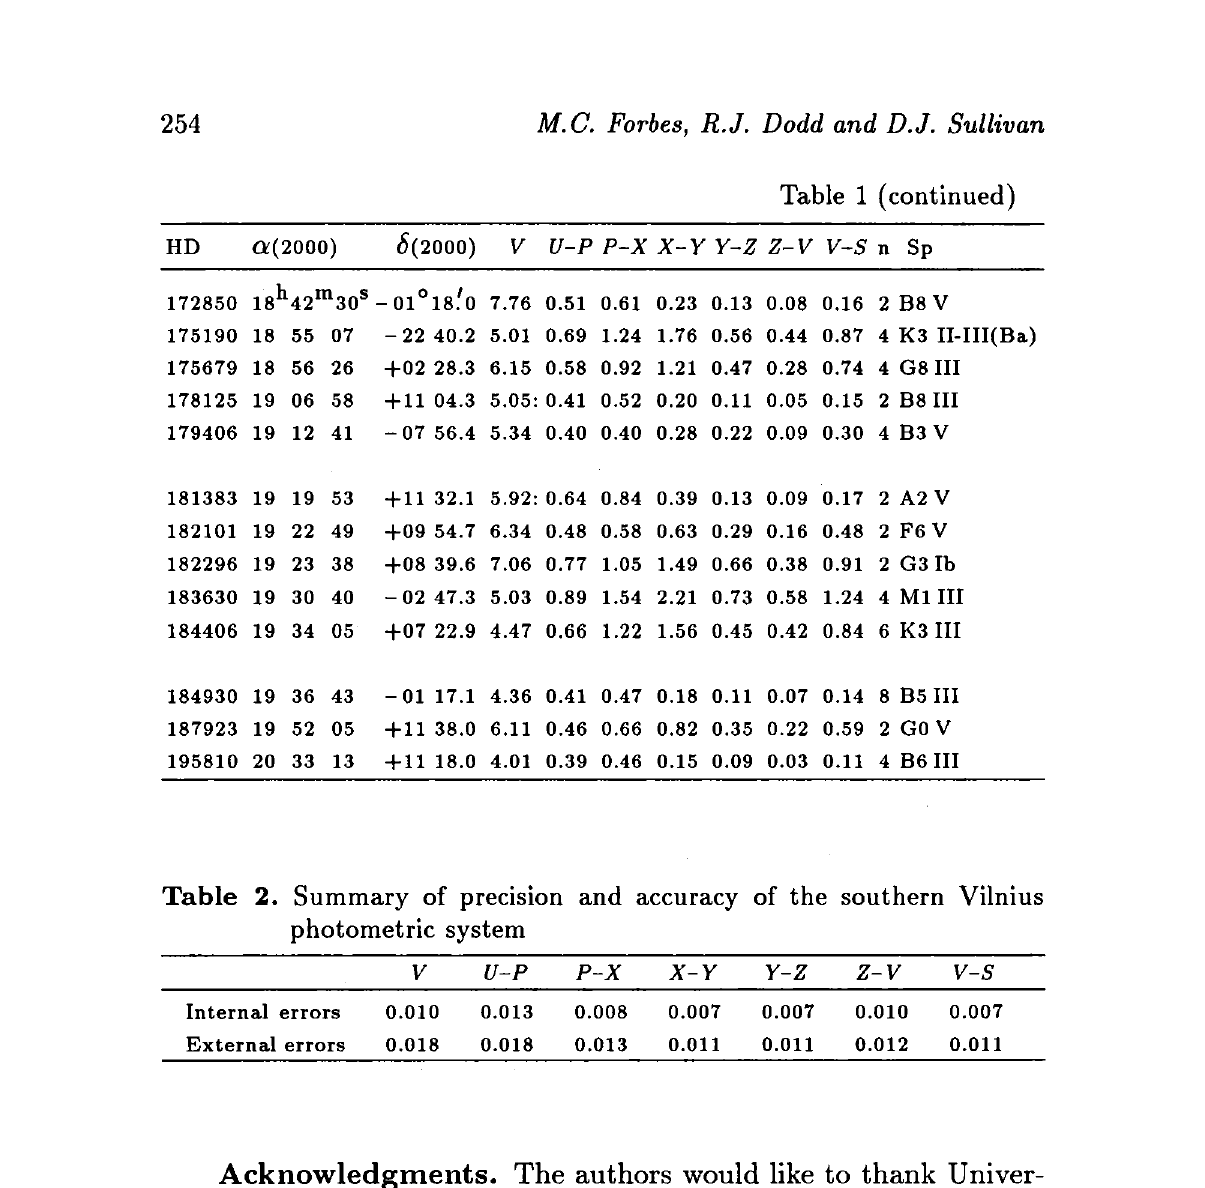
Table 2. Summary of precision and accuracy of the southern Vilnius photometric